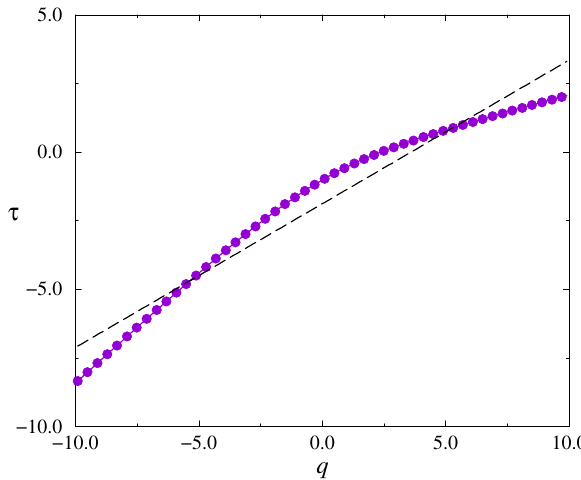
Fig. 5. Typical spectrum of scaling exponents showing a nonlinear dependence (cid:1) ð q Þ .